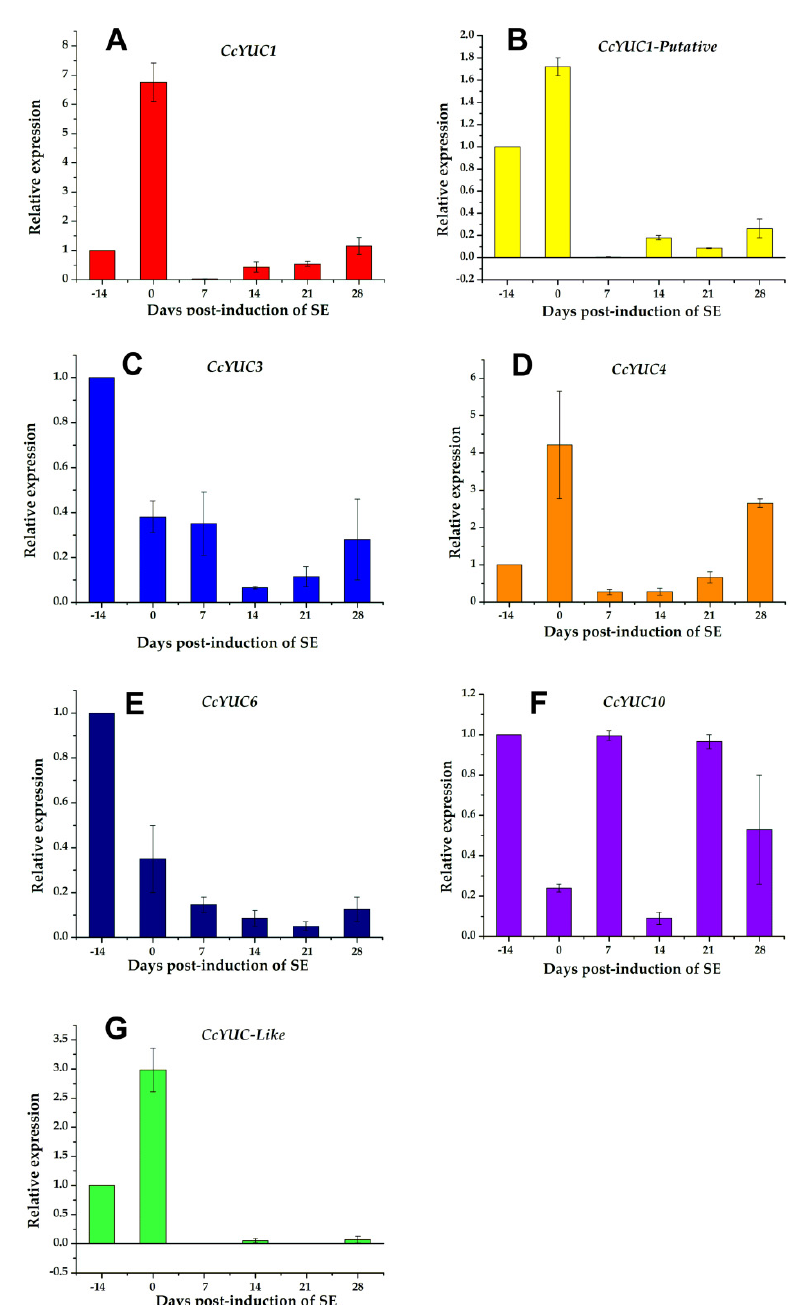
Figure 5. Expression levels of individual CcYUC genes during the induction of SE in C. canephora . ( A ), CcYUC1 ; ( B ), CcYUC1 -putative; ( C ), CcYUC3 ; ( D ), CcYUC4 ; ( E ), CcYUC6 ; ( F ), CcYUC10 and ( G ) CcYUC -like. Actin was used as an internal qRT-PCR reference. The bars over the columns represent the mean value ± standard error of three independent